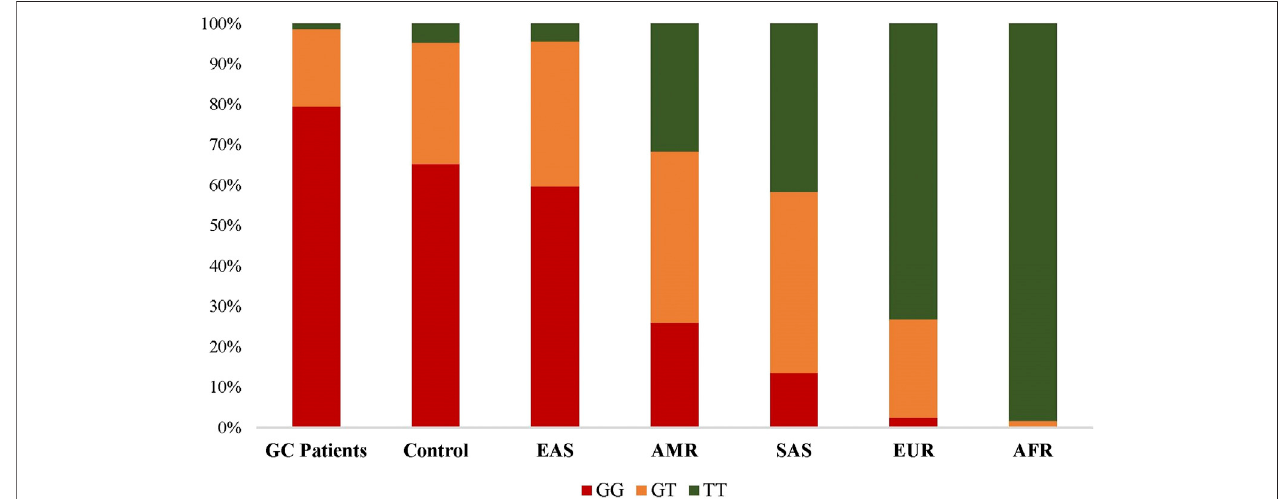
FIGURE 2 | Distributions of EFNA1 rs4971066 genotypes in studies populations and other ethnic populations.